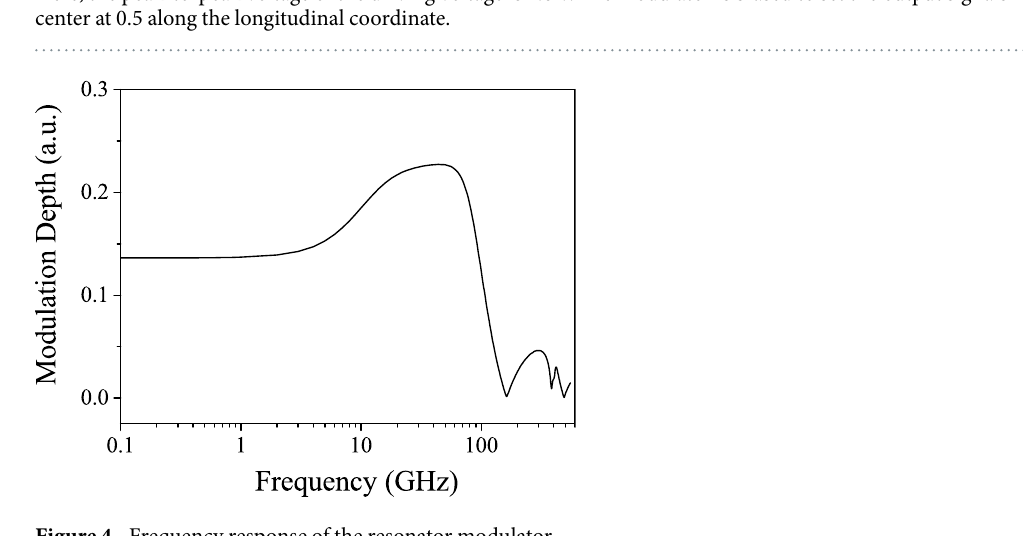
Figure 4. Frequency response of the resonator